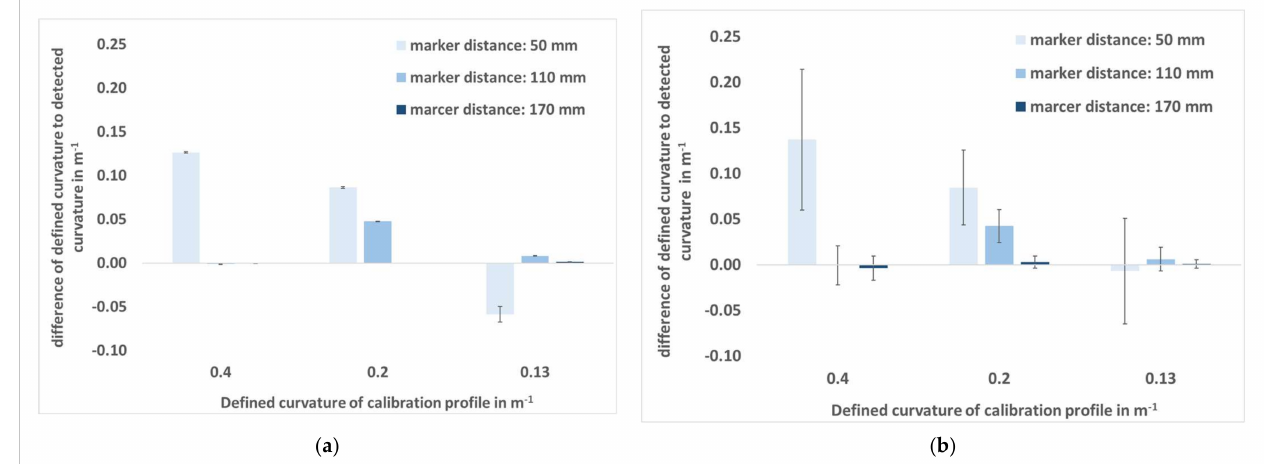
Figure 5. Average difference ± standard deviation (SD) in m − 1 of captured curvature to the defined curvature. ( a ) Calibration profile at rest (v zero ). ( b ) Movement of the calibration profile with mean velocity v fast